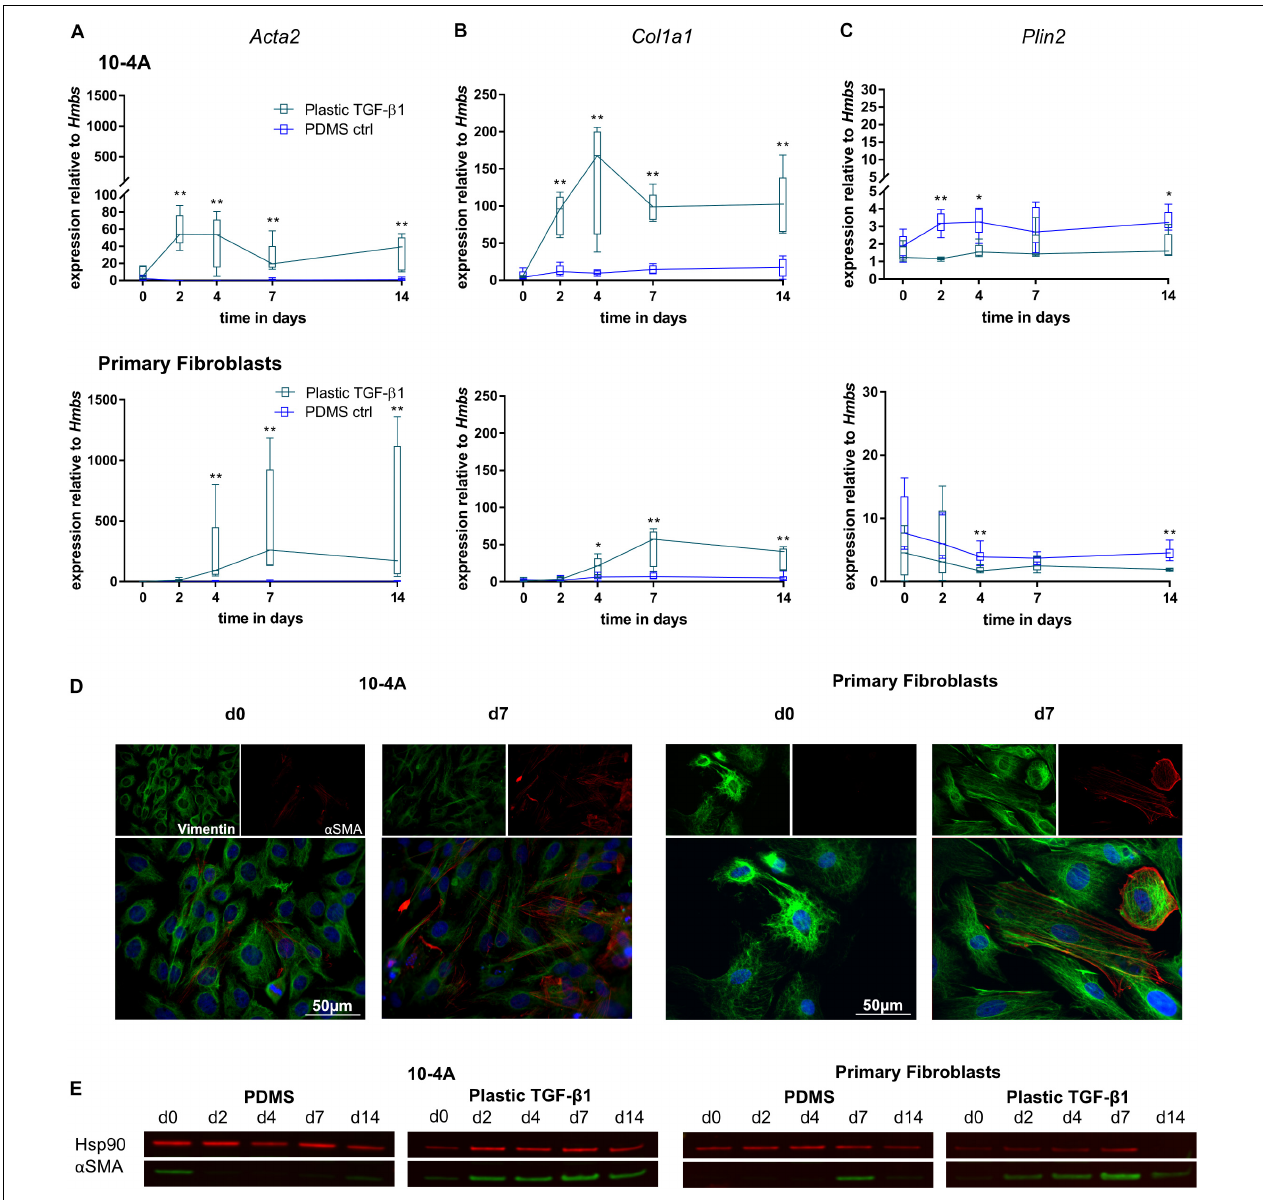
FIGURE 5 | Combination of chemical and mechanical stimulation of 10-4A cells and primary fibroblasts with TGF- β 1 on a physiological substrate. Semi-quantitative RT-PCR of Acta2 (A) , Col1a1 (B) , and Plin2 (C) expression in 10-4A cells (top graph) and primary fibroblasts (bottom graph) cultured on either soft substrate (PDMS) or in the presence of 5 ng/ml TGF- β 1 stiff substrate (Plastic), respectively. Data are expressed as fold expression of housekeeping gene Hmbs . Primary fibroblast data were obtained from five different animals, 10-4A data from five independent cell culture experiments. The respective time points were tested with the non-parametric Mann–Whitney- U -Test. Statistical significance is indicated as follows: p -values < 0.05: *, p -values < 0.01: **. Box plots show data as median values, the boxes represent percentiles, the whiskers indicate the minimum/maximum. (D) Immunofluorescence staining of 10-4A cells (left) or primary fibroblasts seeded on PDMS with administration of 5 ng/ml TGF- β 1 directly after adherence (d0) or 7 days post-seeding. Cells were stained for the mesenchymal marker Vimentin (green) and the pro-fibrotic protein α SMA (red). Scale bar = 50 µ m. (E) Western Blot for α SMA in 10-4A cells and primary fibroblasts cultured over 14 days on